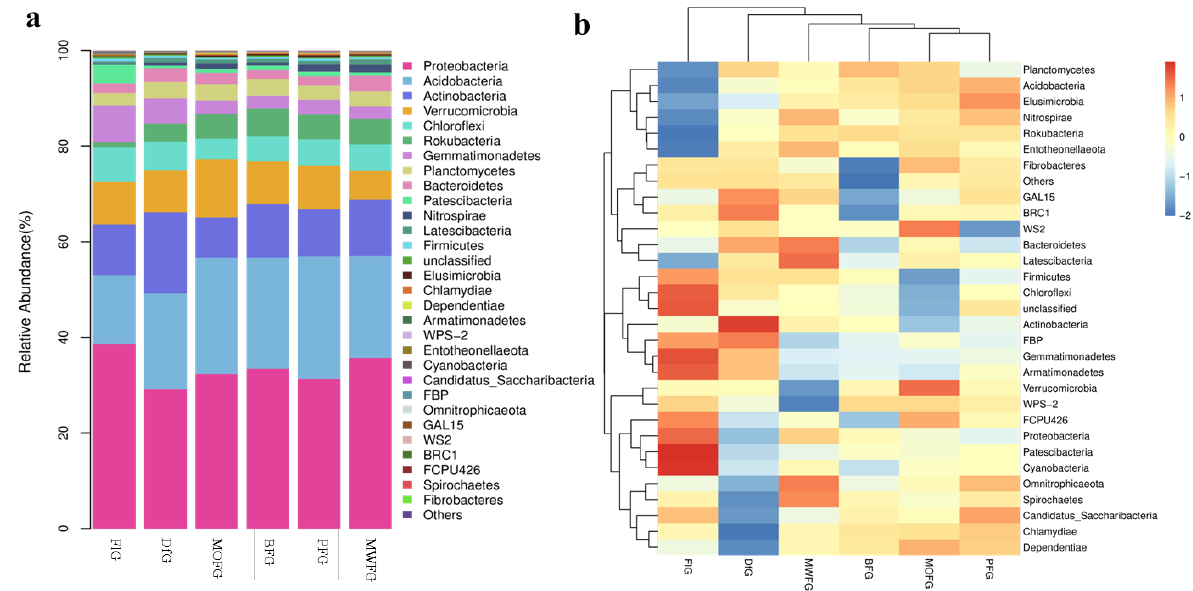
Figure 3. Stripe ( a ) and heat map ( b ) of the relative abundance of bacteria at the gate level. MOFG, Mongolian oak forest ginseng; BFG, birch forest ginseng; MWFG, miscellaneous wood forest ginseng; PFG, poplar forest ginseng. FlG, farmland ginseng; DfG, deforestation ginseng. The fringe pattern ( a ) and thermal pattern ( b ) of the relative abundance of bacteria at the gate level reflect the change in the abundance from low to high with the gradient color from blue to red. The closer the color to blue, the lower the abundance, and the closer to red, the higher the abundance. The heat map is transformed by the Z value to normalize the expression abundance of the same